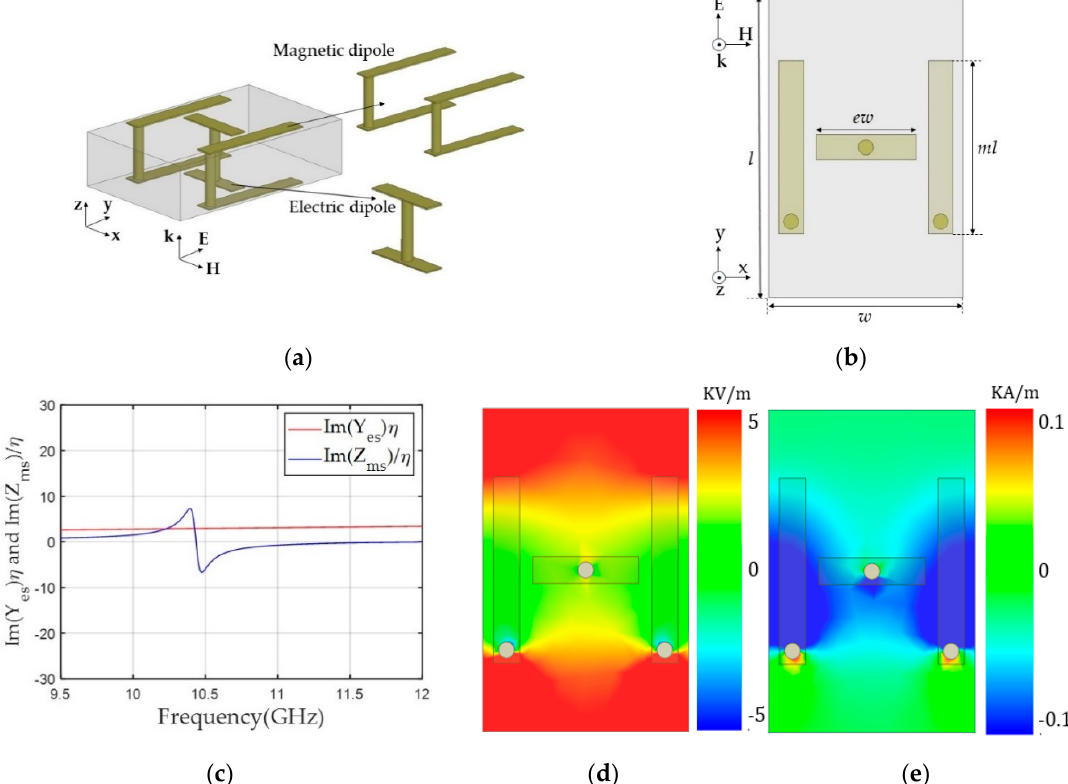
Figure 7. Electric and magnetic dipoles in the topology 2 structure from the ( a ) side-side view and ( b )